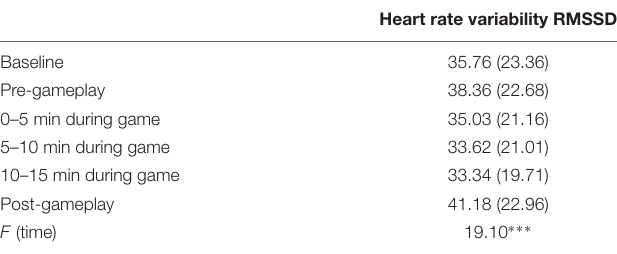
TABLE 4 | Changes in mean (SD) heart rate variability (RMSSD) before, during and after game